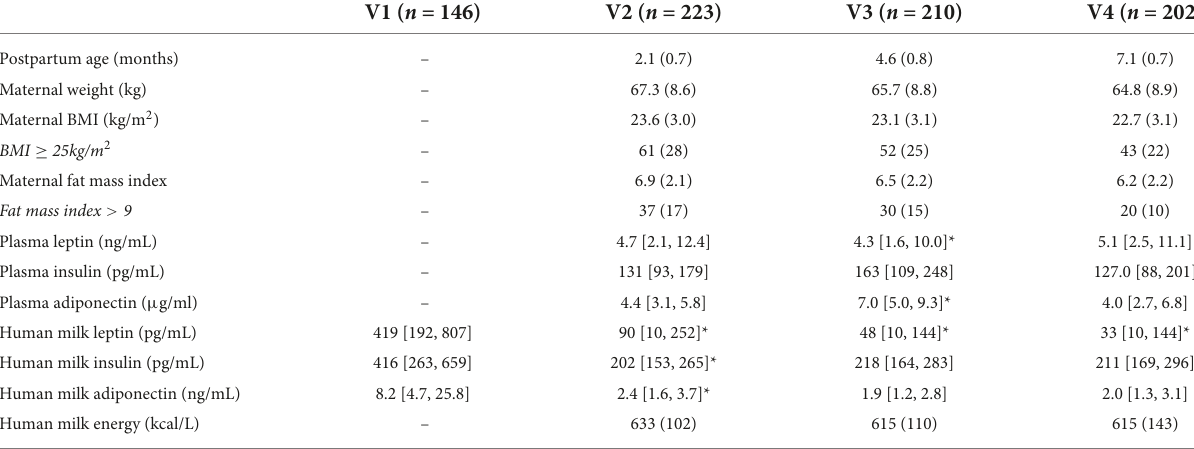
TABLE 2A Maternal anthropometry, body composition and plasma and human milk hormone concentrations at the three postpartum visits.